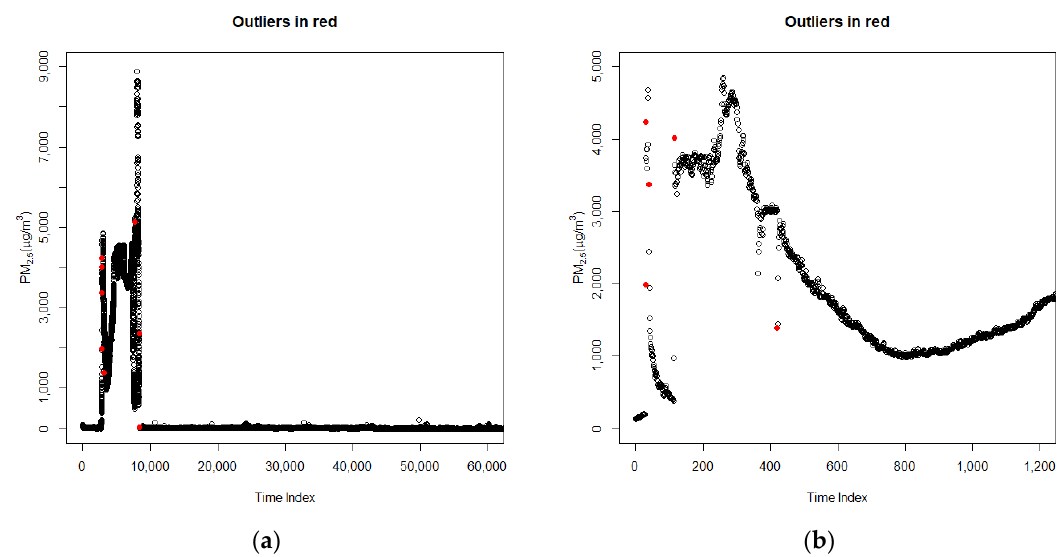
Figure 9. Anomalies are detected and shown in red ( a ) outliers for the entire dataset ( b ) outliers shown enlarged for the part of the dataset between 2750 and 4000.